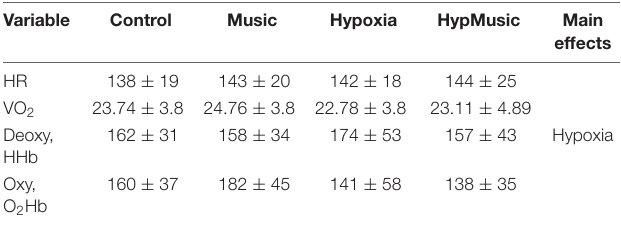
TABLE 1 | Physiological measures of mean heart rate (HR, bpm), oxygen consumption (VO 2 , ml · kg − 1 · min − 1 ), muscle deoxygenation (HHb), and muscle oxygenation (O 2 Hb) across